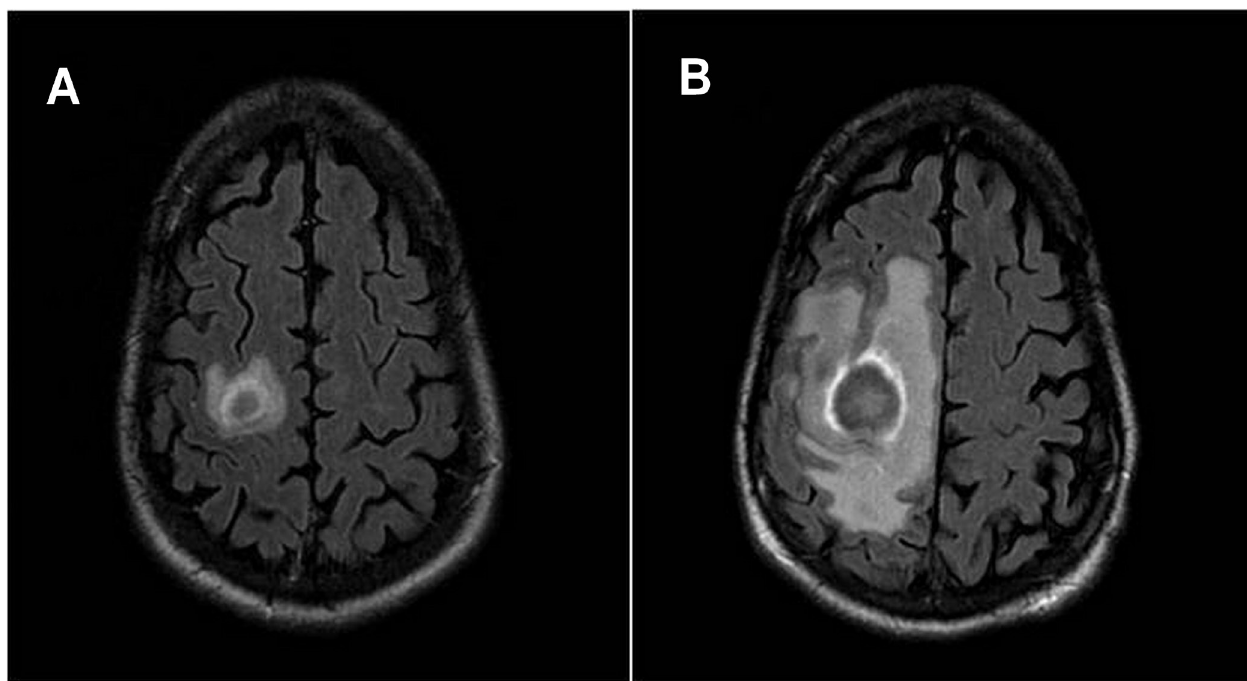
Figure 1. Brain MRI of patient 1 at presentation showed an ill-defined 1 cm right medial occipitotemporal gyrus mass and a 1.8×1.7×1.5 cm mass in the subcortical white matter of the right precentral gyrus with surrounding edema ( A ). After 14 days of anti-toxoplasma treatment and antiretroviral therapy, a follow-up MRI revealed enlargement of the prior right precentral gyrus lesion now to maximum size of 2.2 cm ( B